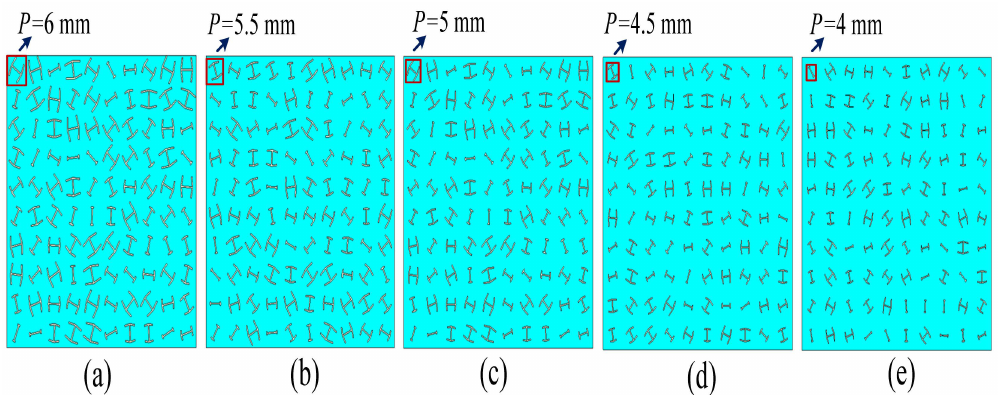
Figure 12. Comparisons of RCS reduction with di ff erent period length p .